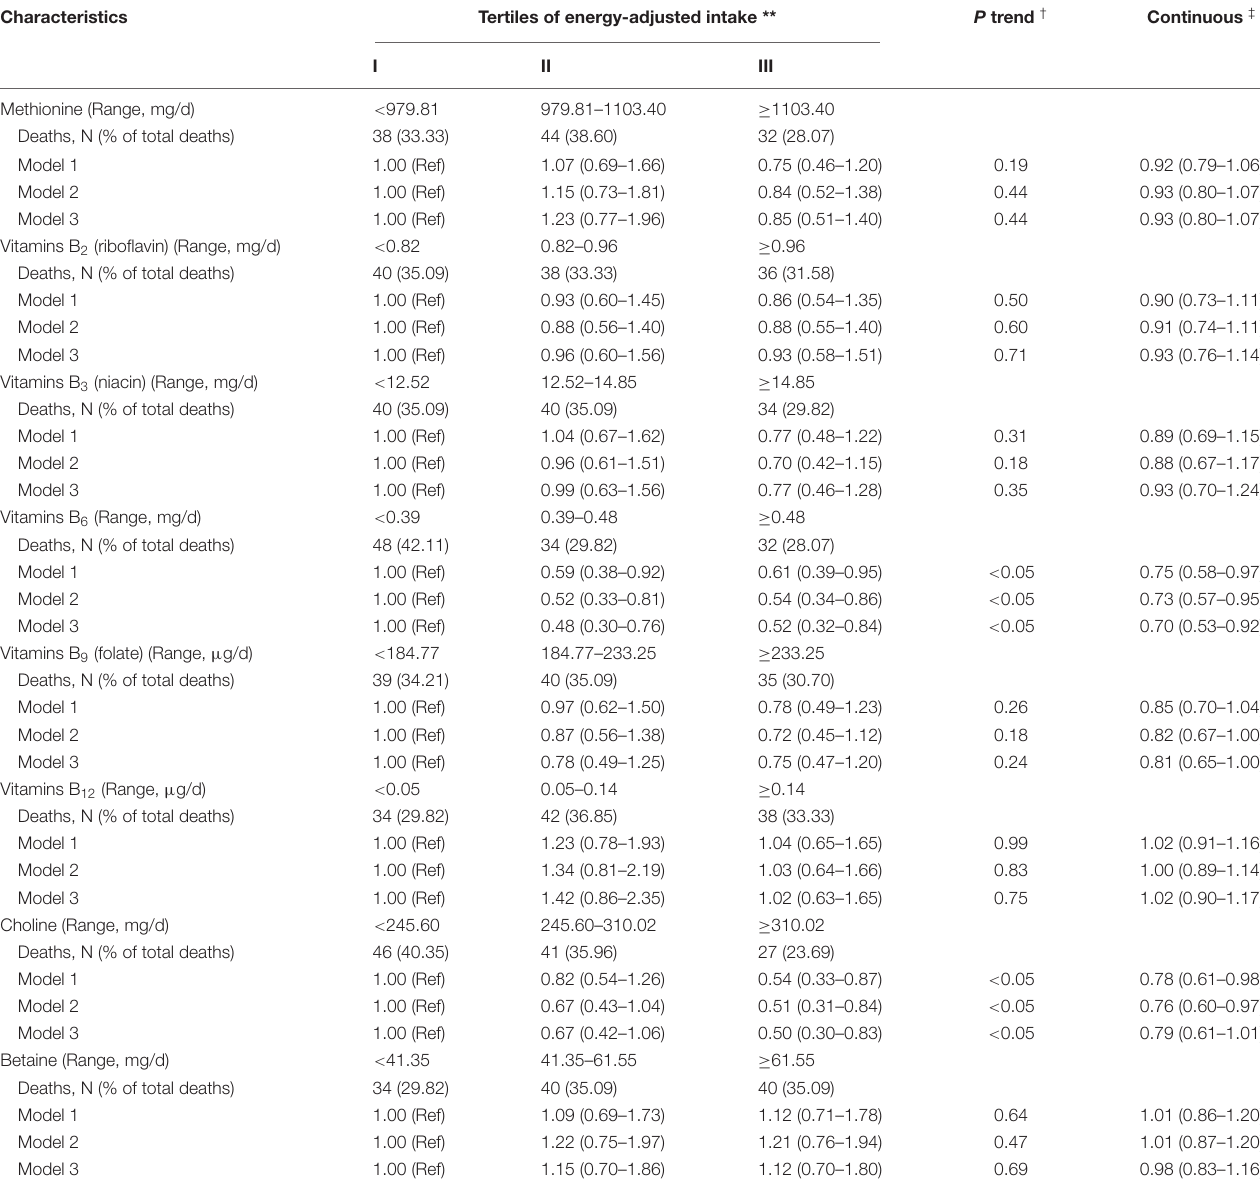
TABLE 2 | Adjusted hazard ratio (HR) and 95% confidence intervals (CIs) for the association between dietary one-carbon metabolism micronutrients intake and total mortality of ovarian cancer ( n = 635)*. Characteristics Tertiles of energy-adjusted intake